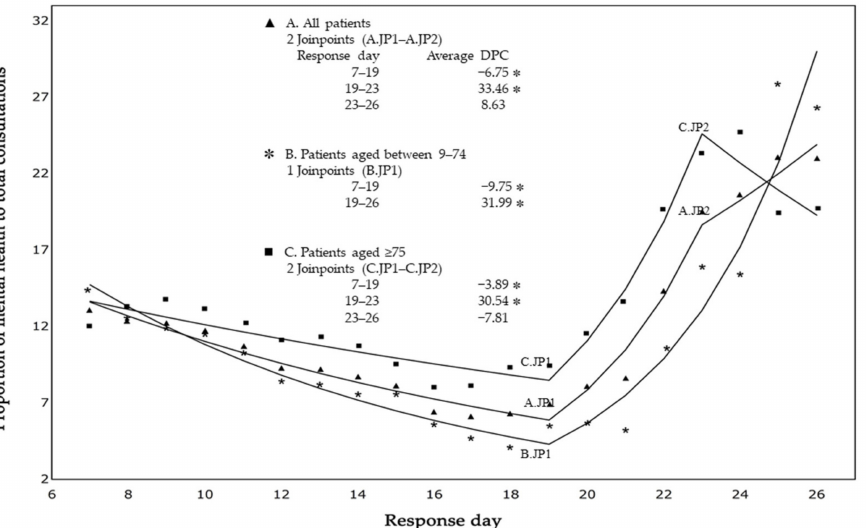
Figure 3. Trends in the proportion of mental health to total consultations. JP, joinpoint; DPC, daily percentage change. * Joinpoint regression analysis; p <